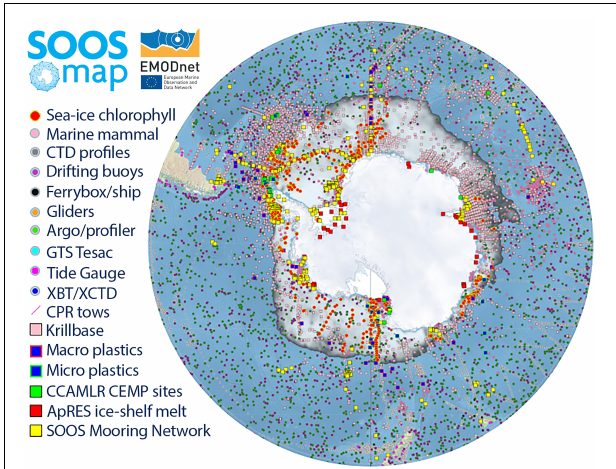
FIGURE 3 | SOOSmap is an interactive webmap that allows users to explore circumpolar datasets. It was developed for SOOS by EMODnet Physics and enables users to search within different spatial and temporal filters, and to select different platforms, variables, and data layers. SOOSmap is an open access and provides direct data downloads where possible